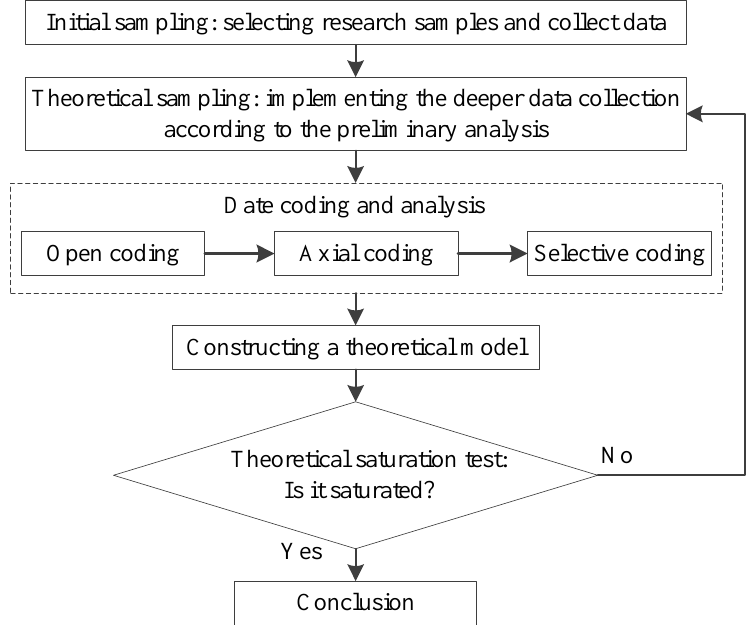
Figure 3. The implementation steps for grounded theory.